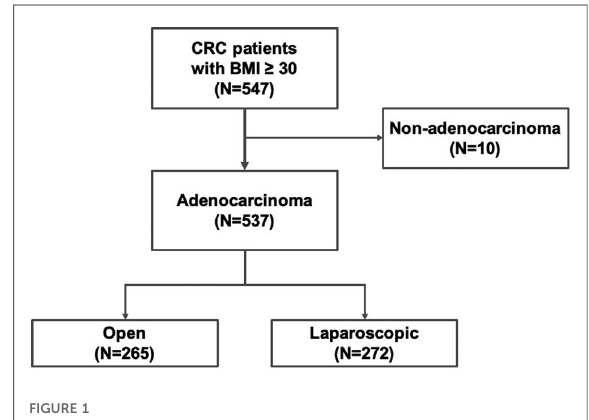
FIGURE 1 Flow chart of patient screening and